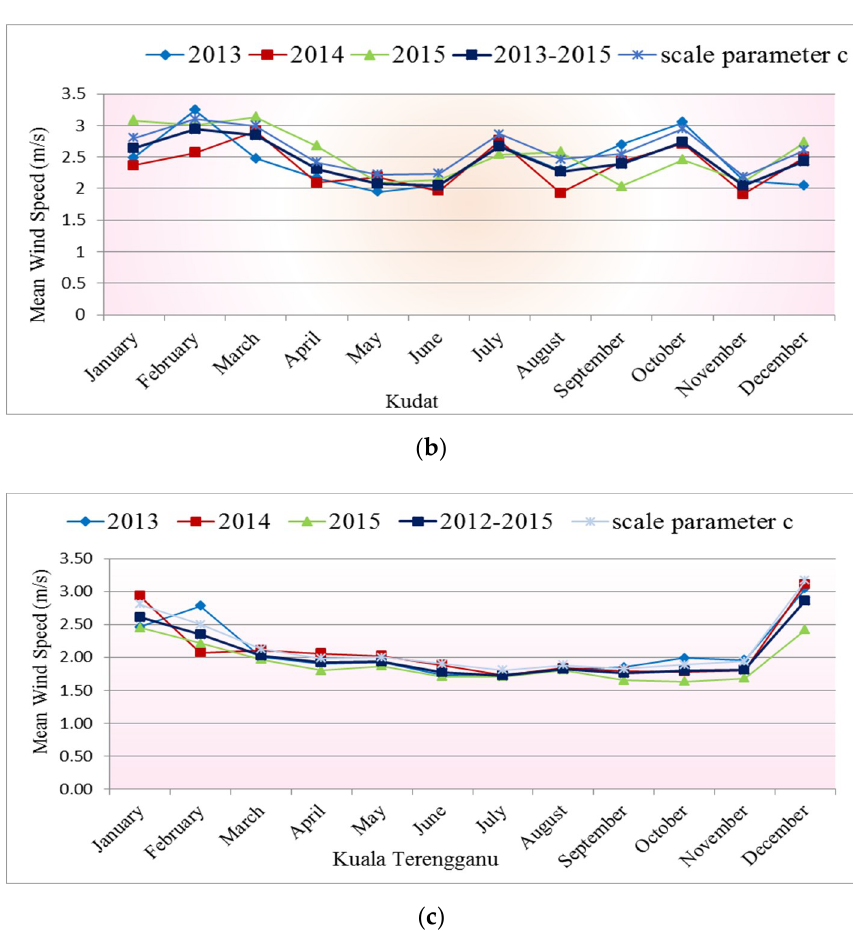
Figure 5. Comparison between monthly mean wind speed data and the scale parameter ( c ) over 3 years period at sites ( a ) Mersing, ( b ) Kudat, and ( c ) Kuala Terengganu.